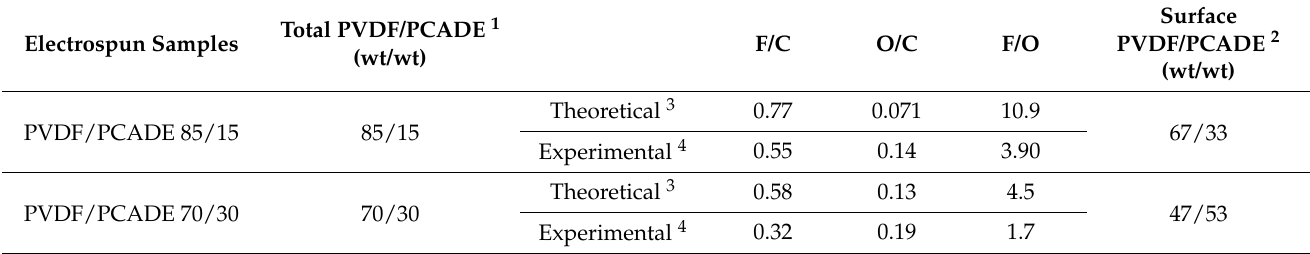
Table 1. Surface composition of PVDF/PCADE blends by XPS